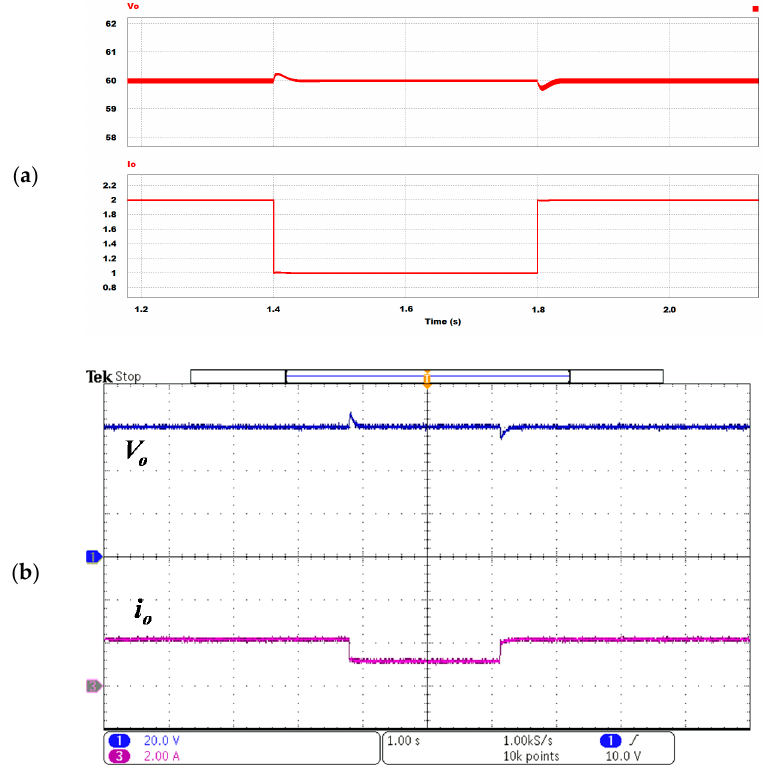
Figure 19. Waveforms of transient response in the load period steps from 120 W to 60 W and then back to 120 W. ( a ) Simulated waveforms; ( b ) Experimented waveforms.